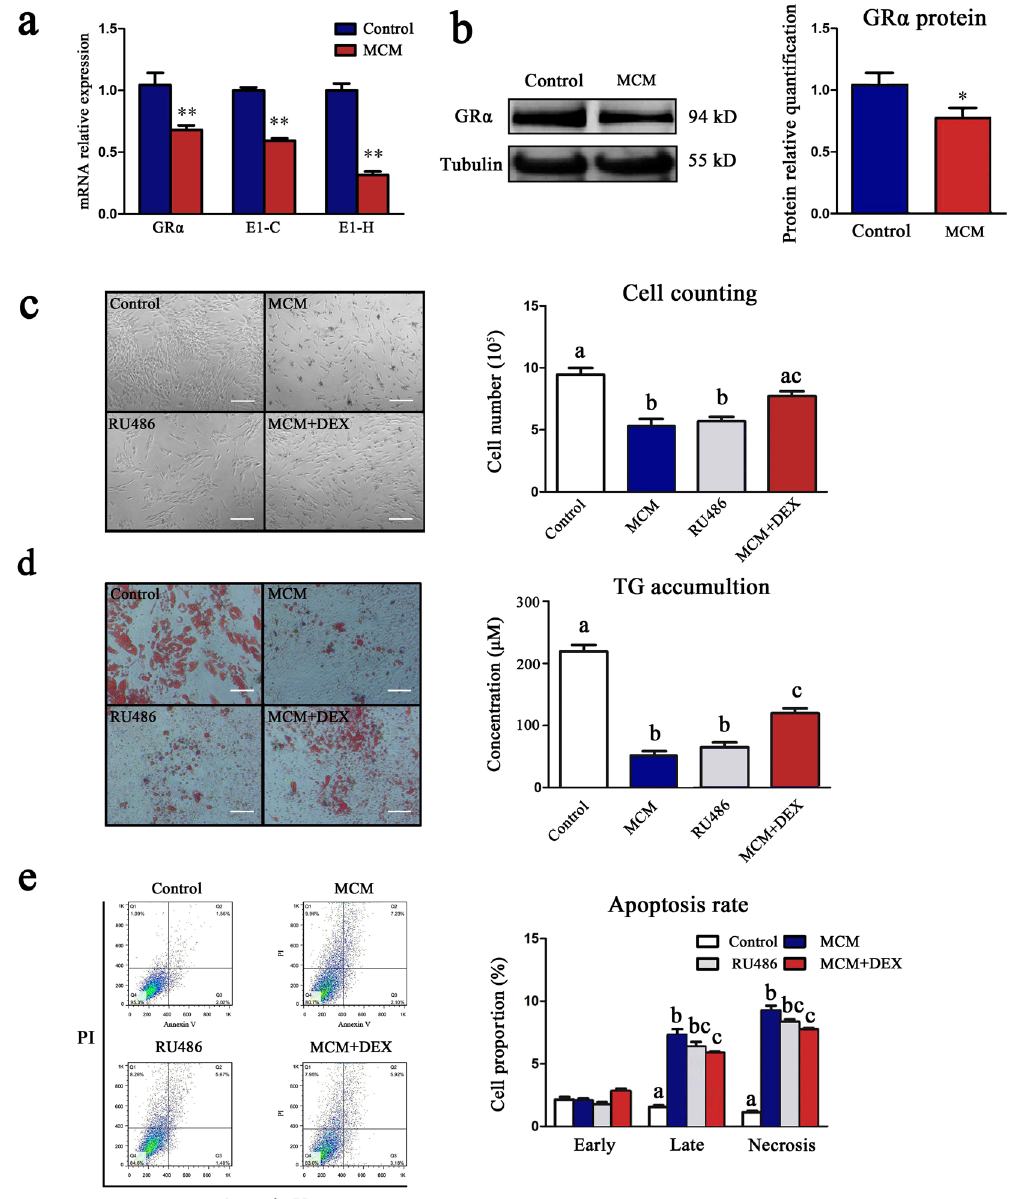
Figure 4. Skeletal muscle conditioned medium inhibited the adipogenesis by reducing GR α expression. The subcutaneous pre-adipocytes were cultured with skeletal muscle conditioned medium (MCM) or ordinary medium for 3 days, then the cells were collected for RNA, protein isolation and flow cytometry assay. ( a ) The mRNA expression of GR α and E1-C, E1-H was detected by RT-qPCR, n = 6 per group. ( b ) Expression of GR α protein was detected by Western blot (left) and displayed as column charts after quantification (right), n = 3 per group, * P < 0.05. ( c ) The effects of MCM on the proliferation of pre-adipocytes were detected by cell imaging (left) and cell counting (right). Cells were cultured with normal culture medium, MCM medium, normal culture medium with 100 nM RU486, or 100 nM DEX + MCM medium respectively, n = 6 per group. The different lowercases mean significant difference (One-way ANOVO, P < 0.05) within the columns, and the same lowercase means no significant difference (One-way ANOVO, P > 0.05), the same below. ( d ) The effects of MCM on the pre-adipocytes differentiation. After reaching confluence, pre-adipocytes were induced to differentiation for 12 days, then the Oil-red O staining (left) and TG assay (right) were conducted. n = 3 per group. ( e ) The effects of MCM on the apoptosis of pre-adipocytes were detected by flow cytometry (left) and displayed as column charts after quantification (right), n = 3 per